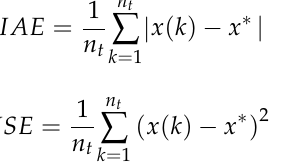
Table 5. Error index of PID in Case 1.